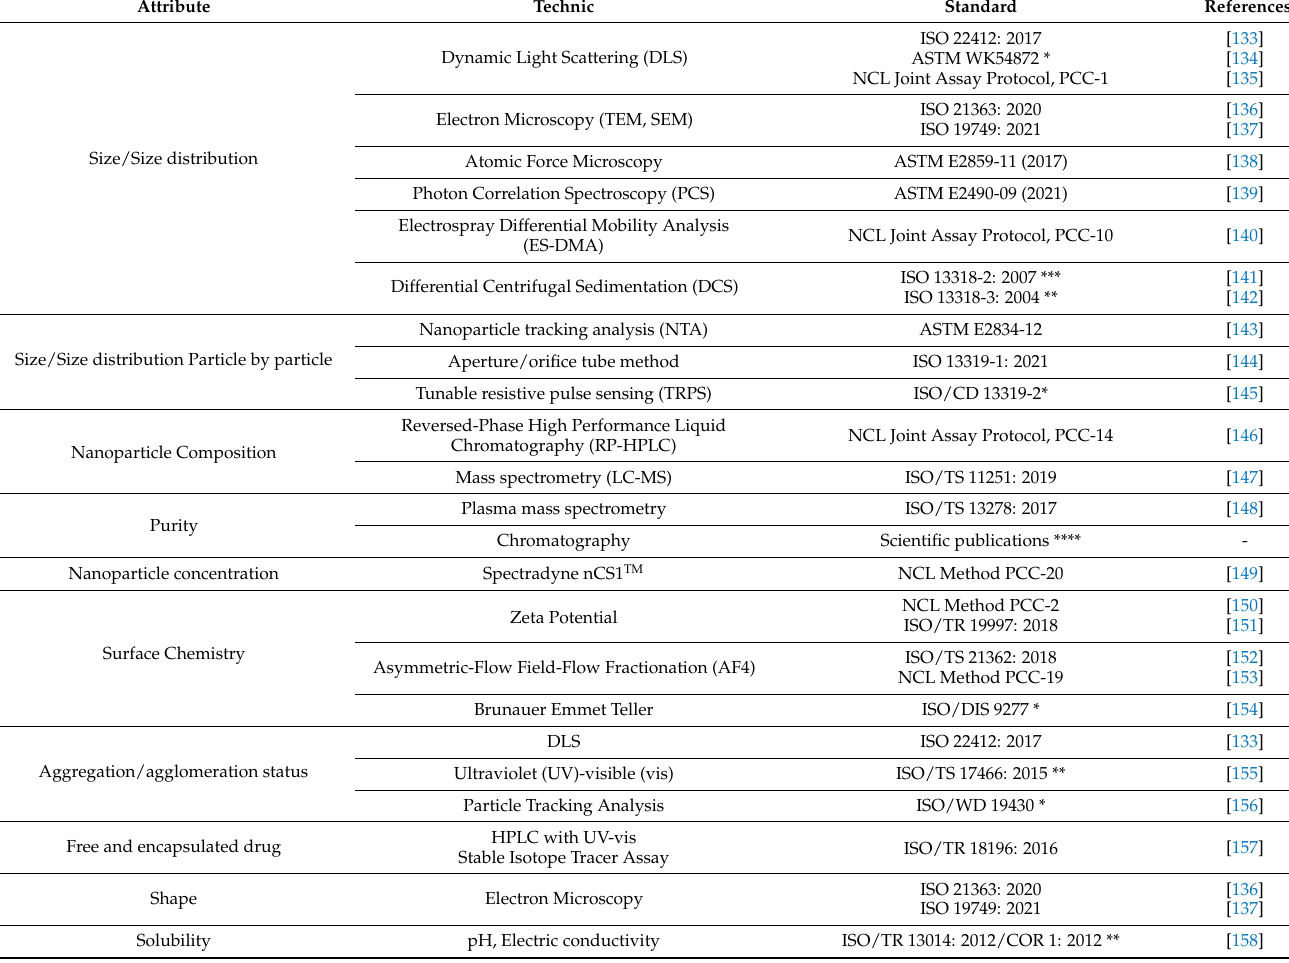
Table 2. Standardized tests for the nanotechnological characterization of NPs